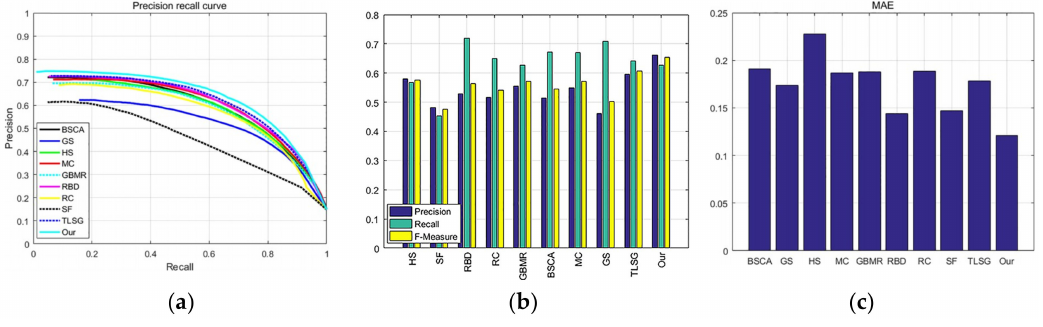
Figure 15. The comparison results on the DUT-OMRON dataset. ( a ) Precision-recall curves. ( b ) Precision, recall, and F-measure at adaptive threshold. ( c ) MAE.